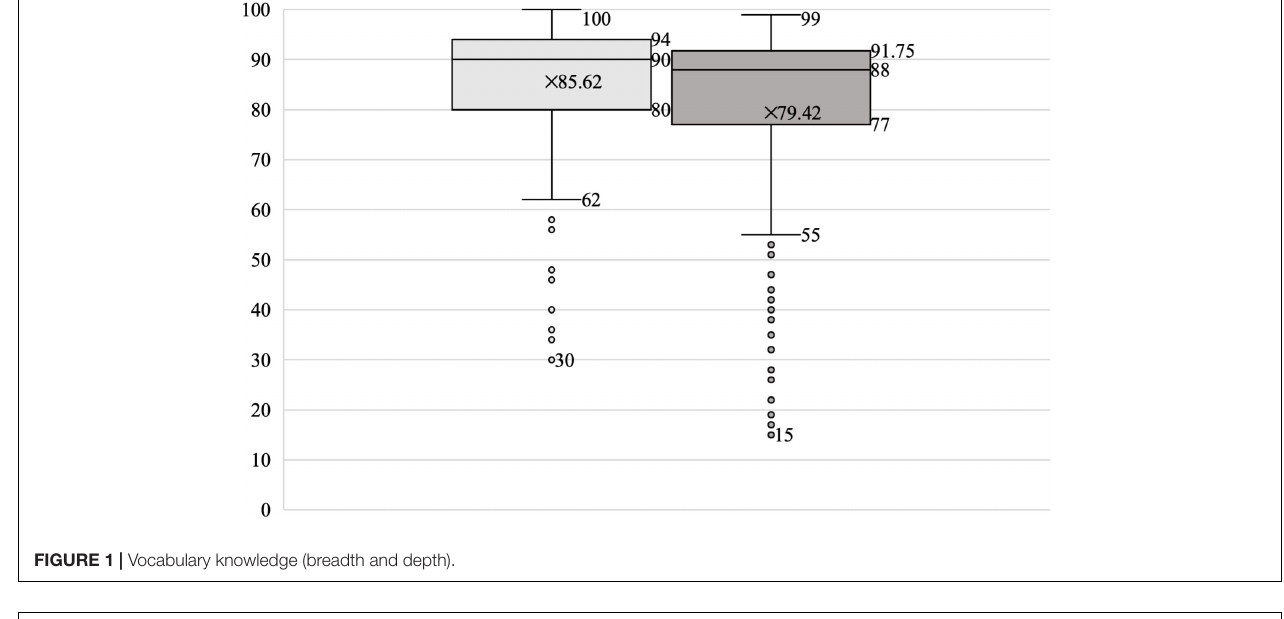
FIGURE 1 | Vocabulary knowledge (breadth and depth).